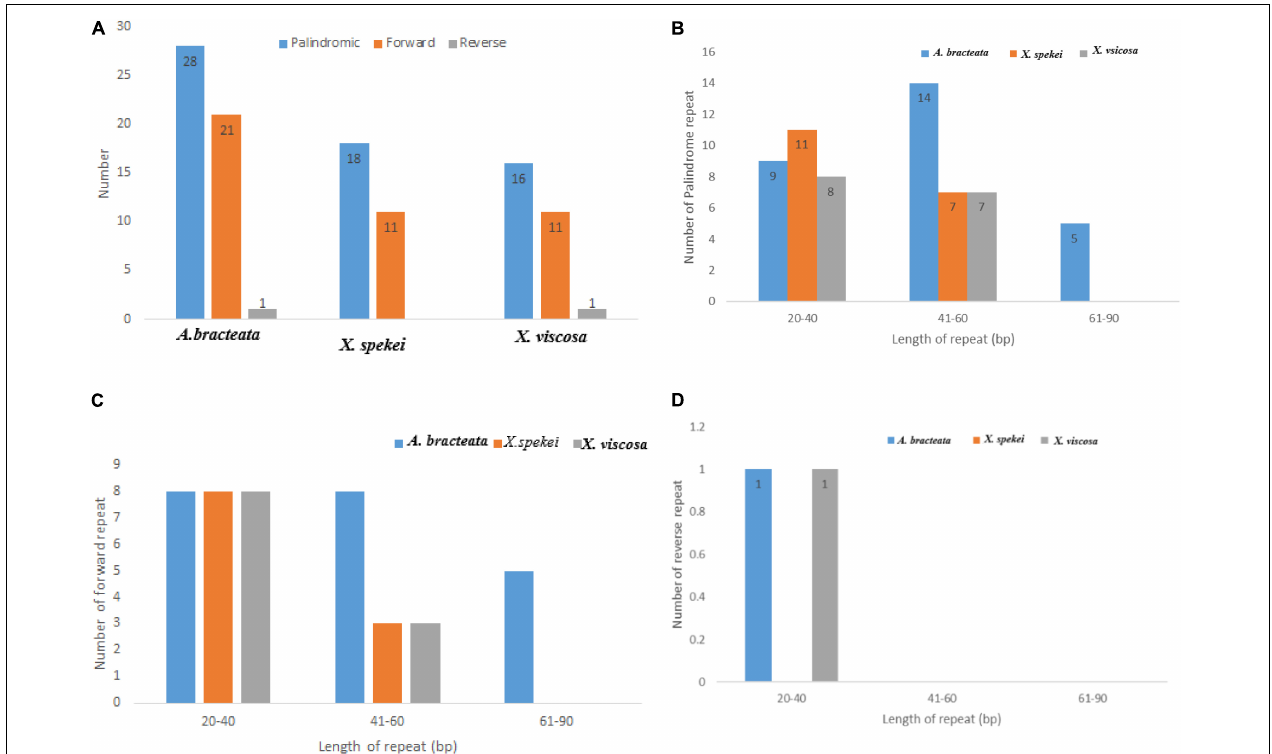
FIGURE 2 | Analysis of the repeat sequences in the whole chloroplast genomes of A. bracteata , X. spekei , and X. viscosa . (A) Total abundance of the three repeats; (B) Total number of the Palindromic repeats; (C) Total number of the forward repeats; (D) Total number of the reverse repeats.